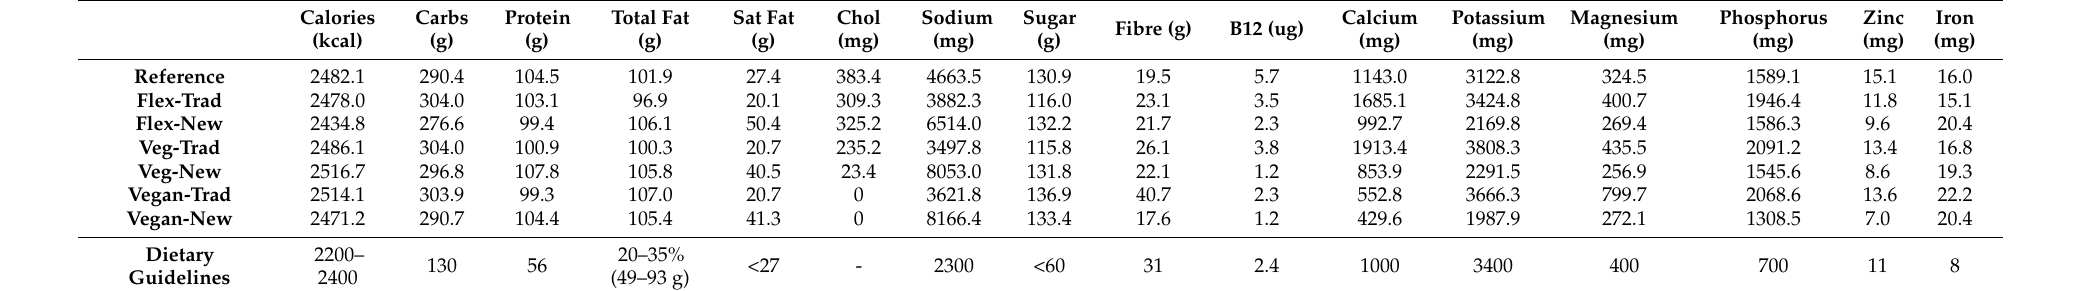
Table 2. Nutritional Compositions of Reference, Flexitarian, Vegetarian and Vegan